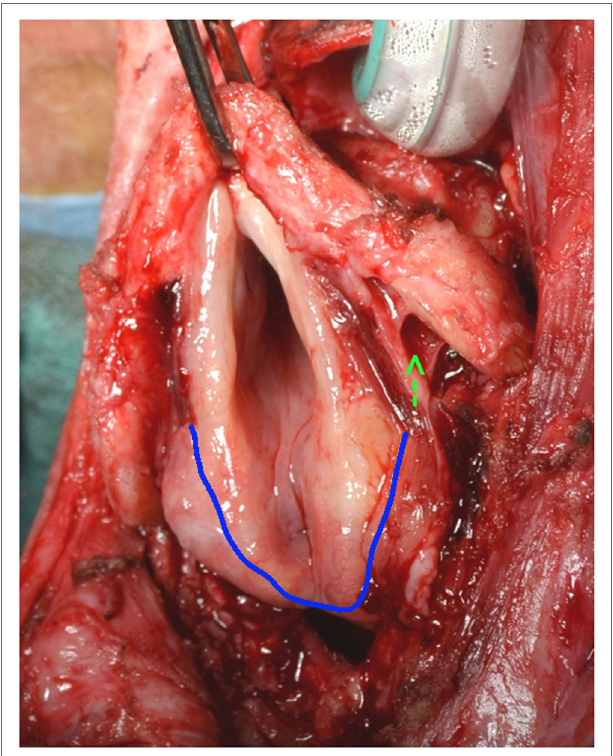
FigUre 4 | Retroarytenoid incision (blue